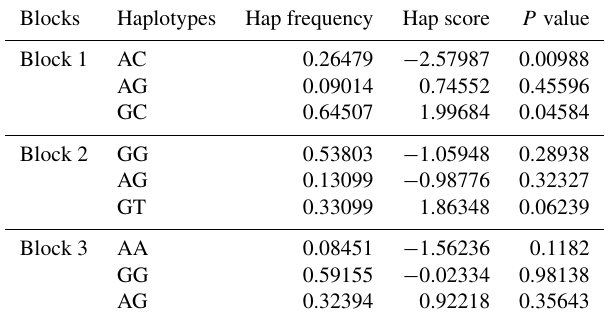
Table 4. Haplotype association analysis of three blocks with litter